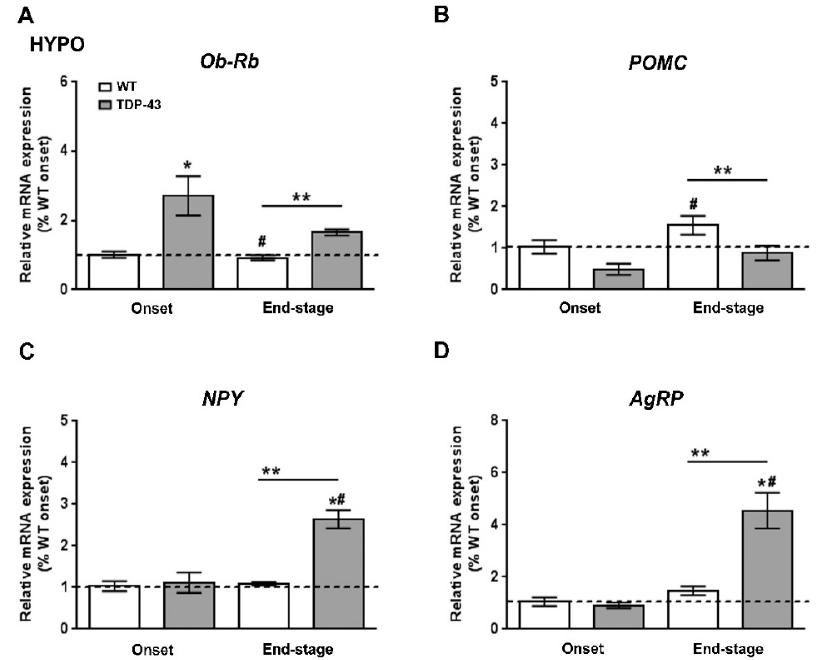
Figure 3. Alterations in Ob-Rb and anorexigenic and orexigenic neuropeptides in the hypothalamus of TDP-43 A315T mice. ( A ) Ob-Rb mRNA expression, ( B ) POMC , ( C ) NPY , and ( D ) AgRP transcripts were assessed by RT-qPCR in TDP-43 A315T mice compared to age-matched WT littermates at both onset and end-stage of disease. Values are expressed as the mean ± SEM for the different groups (n = 5 per genotype/stage of disease). Comparison between groups was performed by two-way ANOVA followed by Dunnett’s post hoc test to compare all groups with WT onset stage, while Tukey’s post hoc test was used for multiple comparisons between all groups, where * p < 0.05 vs. WT onset stage; # p < 0.05 vs. TDP-43 A315T onset; ** p < 0.05 vs. WT end-staged. Abbreviations: HYPO, hypothalamus; Ob-Rb, long form of leptin receptor; POMC, Proopiomelanocortin ; Agrp, Agouti-related protein; NPY, neuropeptide Y.